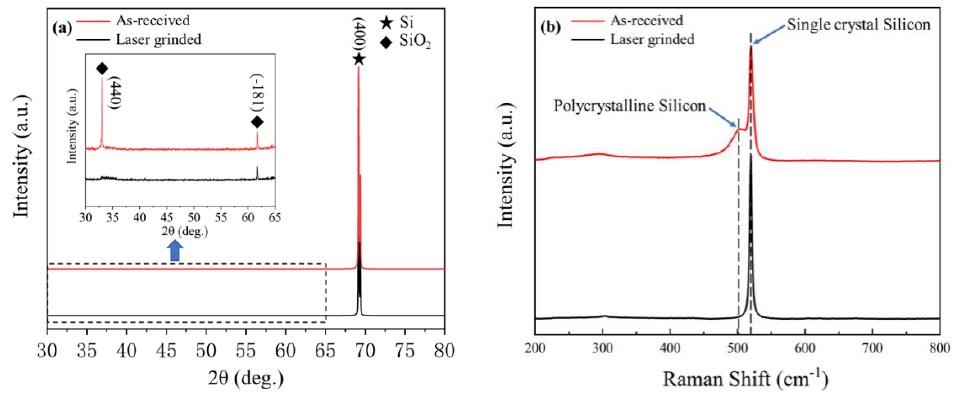
Figure 6. ( a ) XRD and ( b ) Raman spectrums from the laser-grinded surface and the as-received surface.